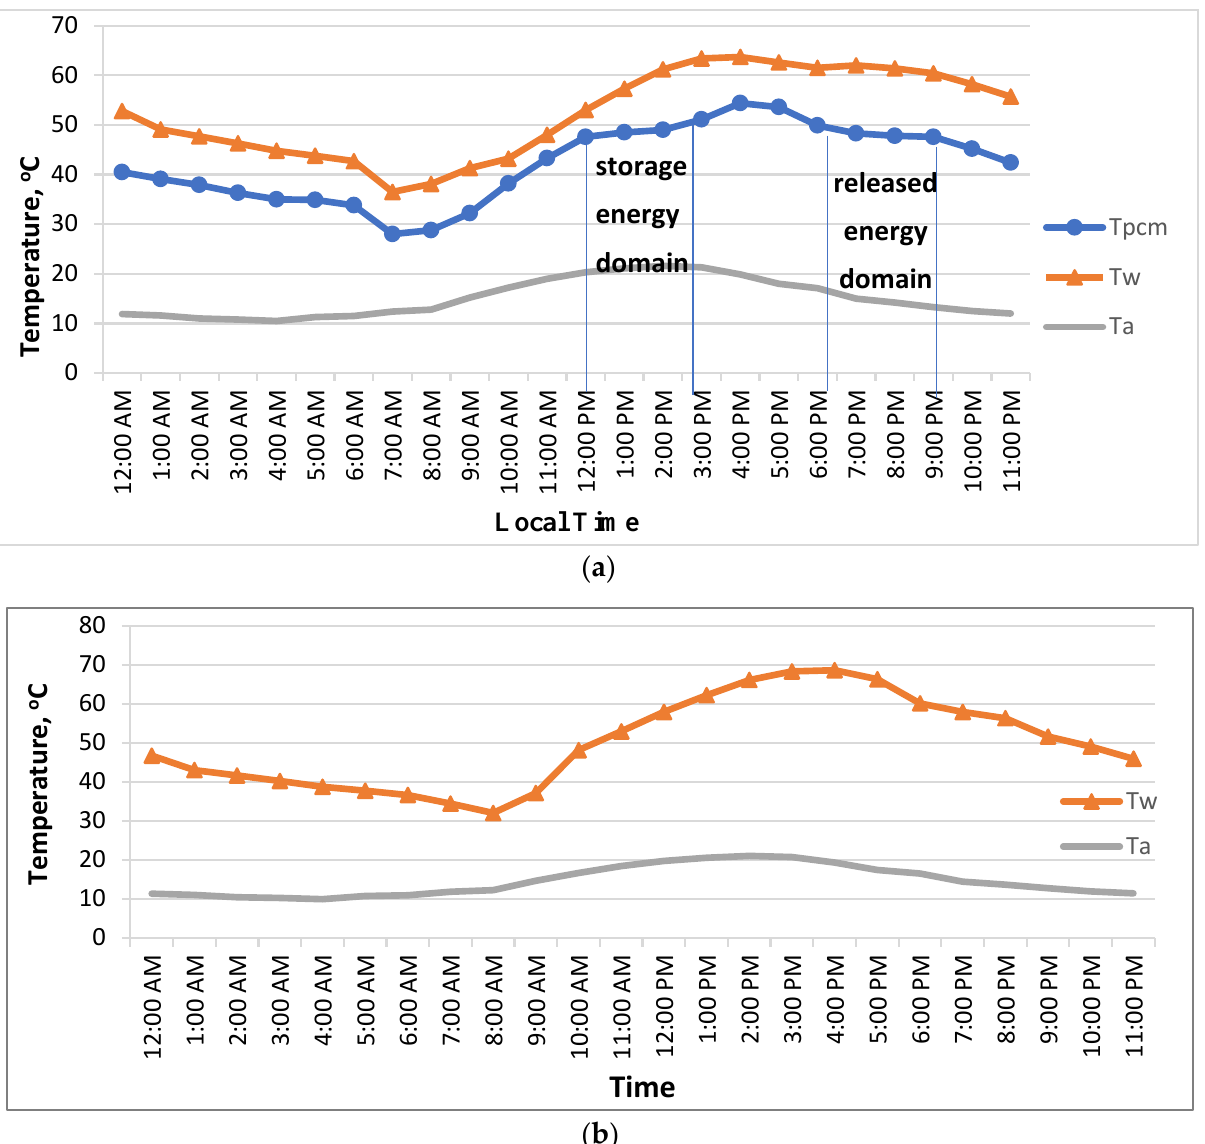
Figure 5. Temperature distribution of the system through December 2021: ( a ) using paraffin as PCM; ( b ) without PCM.